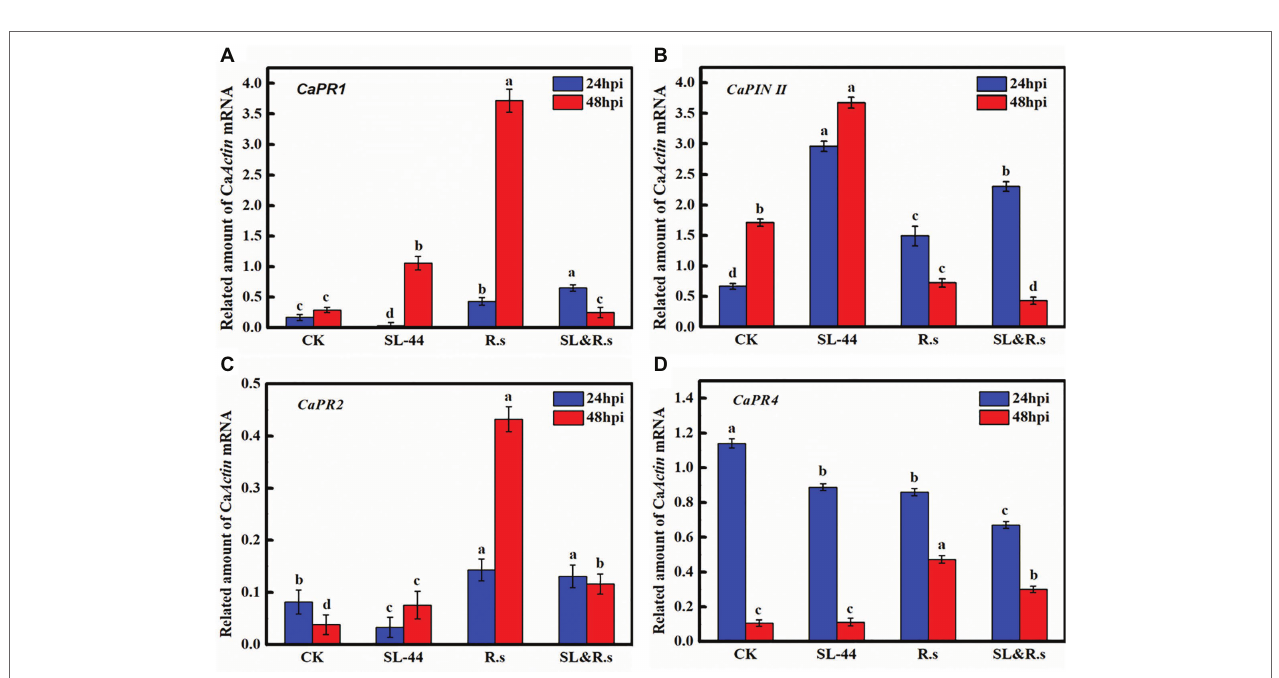
FIGURE 5 | Expression level of the different defense-related gene of pepper foliage in different treatments. (A) CaPR1 , (B) CaPIN II , (C) CaPR2 , and (D) CaPR4 . Each value represents the mean ± SD ( n = 3). Different letters above the columns indicate significant differences at p < 0.05.